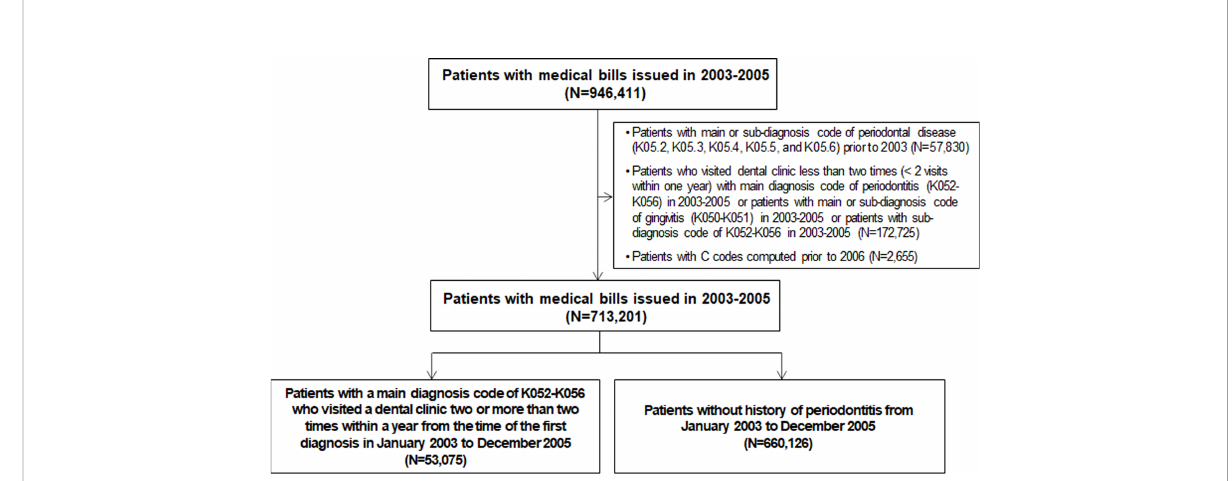
FIGURE 1 Flowchart of selection of the study population from the National Health Insurance Service-Health Screening Cohort database